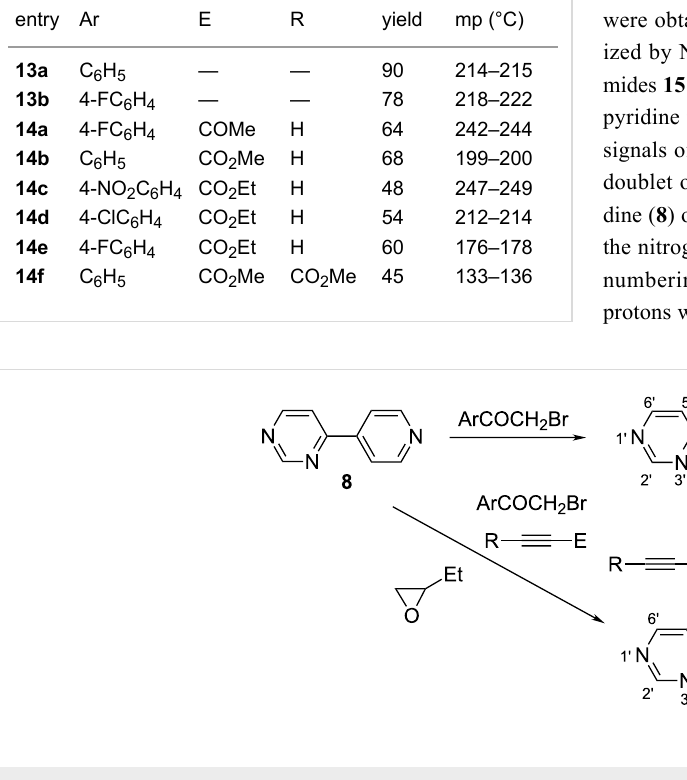
Scheme 3: The synthesis of the new pyridinium bromides 15 and 7-pyrimidylindolizines 16a – f .